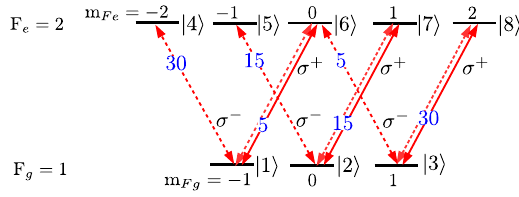
Figure 3. Magnetic sublevels for F g = 1 → F e = 2 transition. The probe beam has σ + polarization, and transitions coupled by it are shown with solid lines. The control beam polarization is varied from σ + to σ − , with transitions shown by dotted lines. The numbers on each arrow are the normalized Clebsch-Gordan coefficients (relative strength) of each